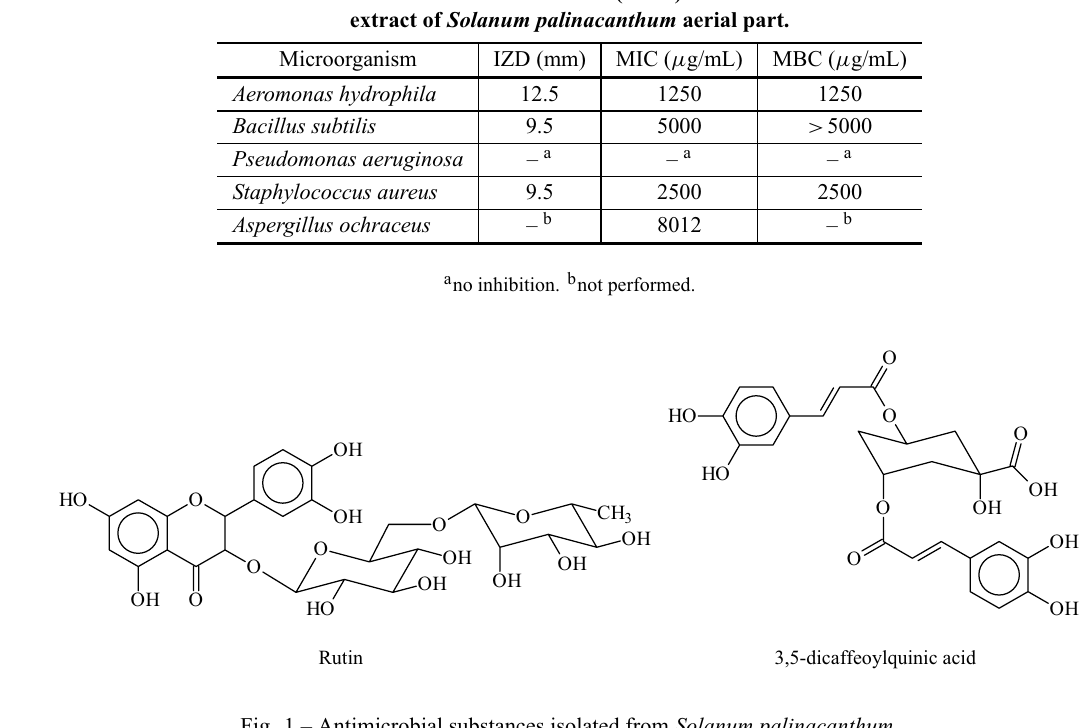
Fig. 1 – Antimicrobial substances isolated from Solanum palinacanthum